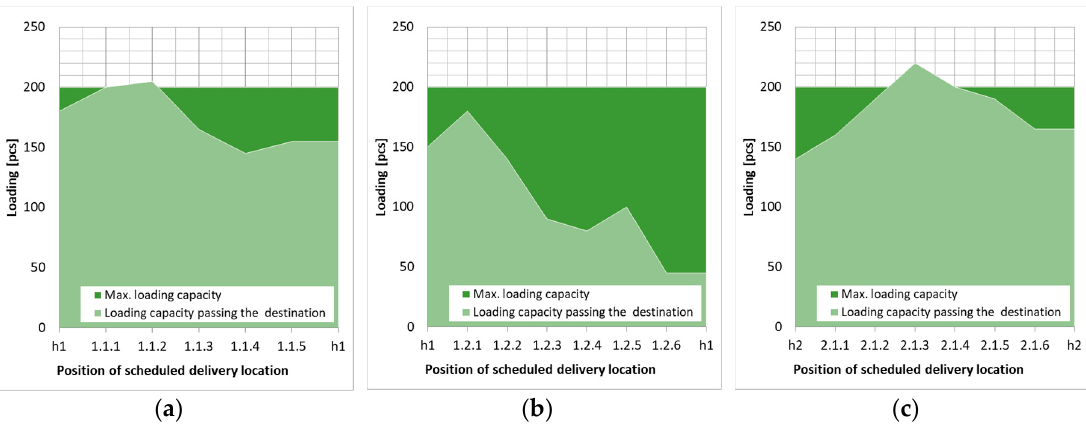
Figure 13. Loading of delivery trucks with scheduled deliveries. The initial loadings are the loading volumes in the h1 and h2 hubs: 170 pcs, 150 pcs, and 140 pcs. ( a ) Loading capacity of delivery truck assigned to route 1 is exceeded after picking up open task 1; ( b ) Loading of delivery truck assigned to route 2; ( c ) Loading capacity of delivery truck assigned to route 3 is exceeded after picking up open task 2.